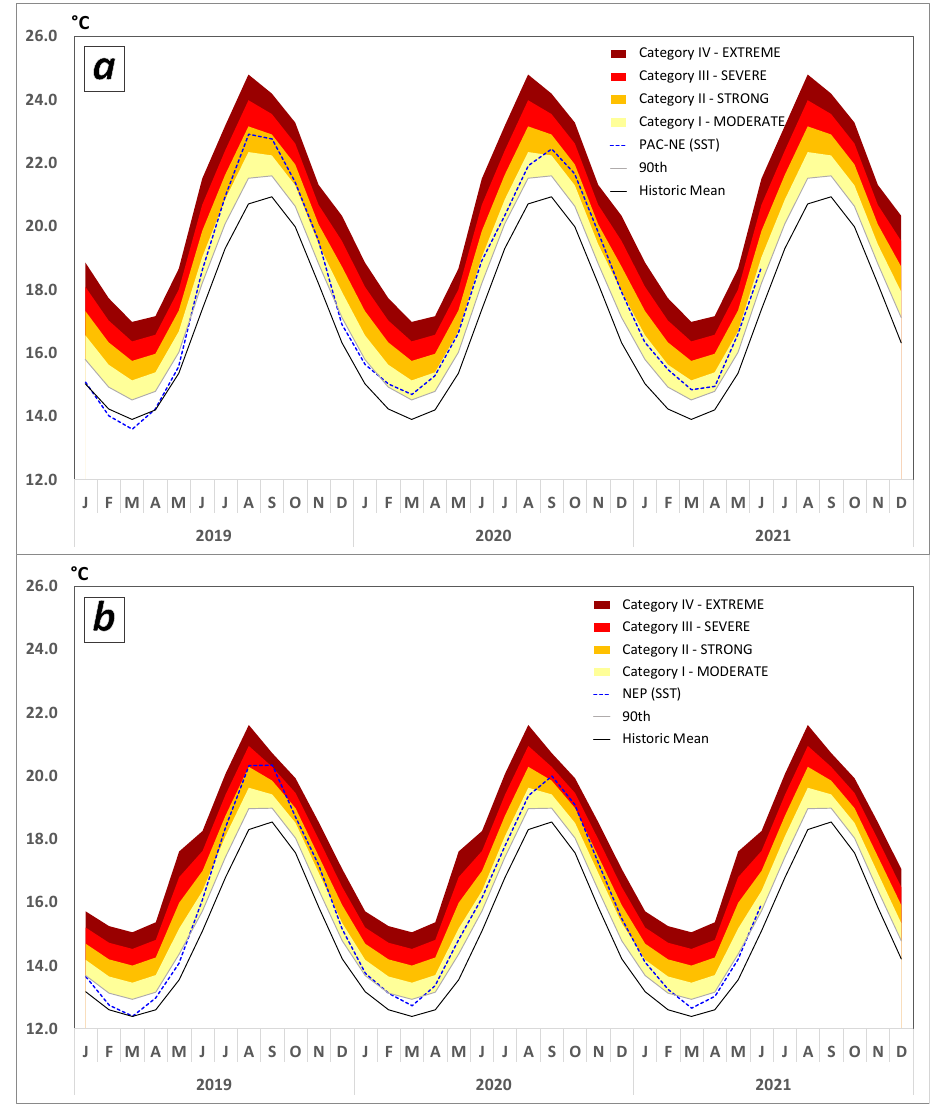
Figure 10. Most recent Marine heatwave (MHW) dynamics (from June 2019 to June 2021 and based on the SST series 1982–2011) at: ( a ) the PAC-NE oceanic region (from Thielen et al. [13]) and ( b ) the NEP —Northeast Pacific SST index region (from CPC/NCEP/NOAA [39] (see Figure 2). MHW categorization is taken from Hobday et al.